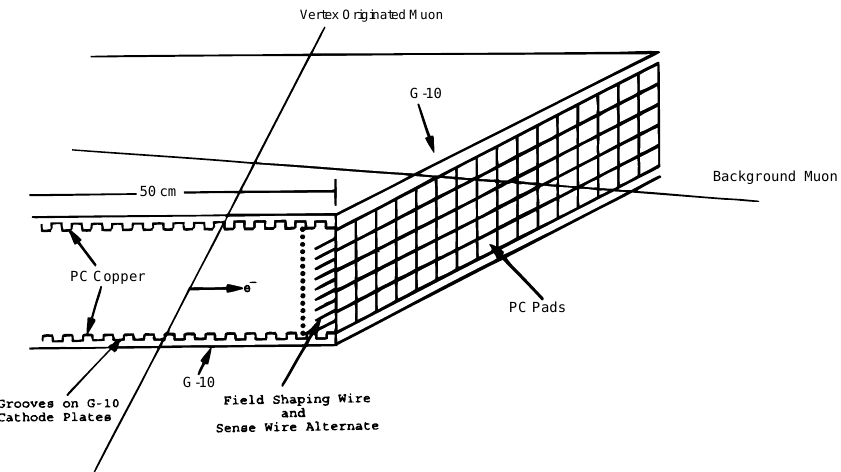
FIG. 76. Long drift jet chamber with pad readout for muon detection at a muon